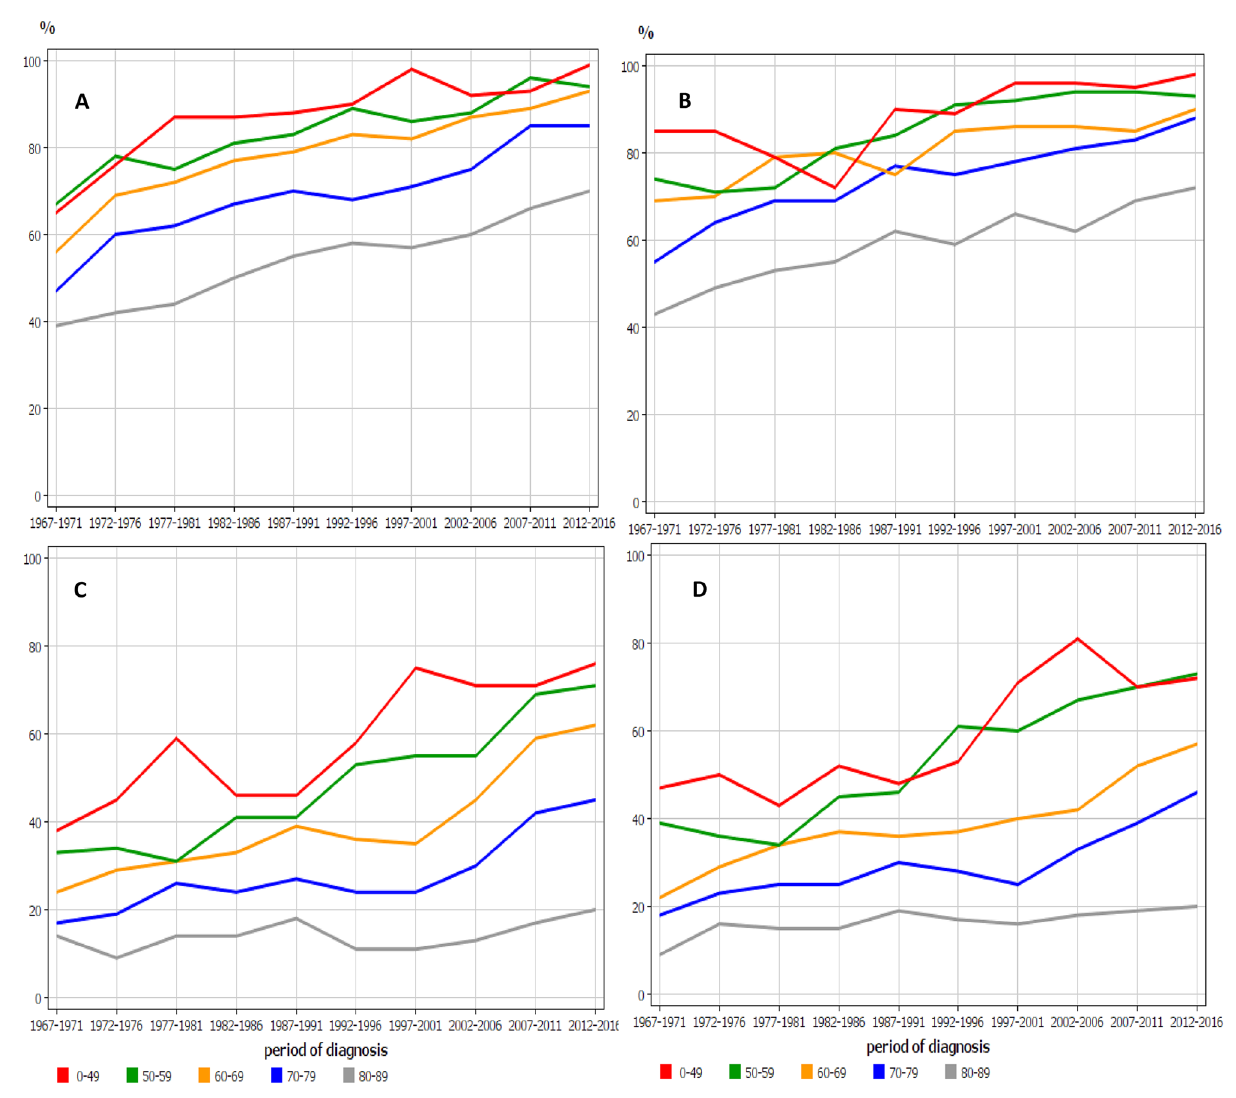
Figure 4. Age-specific 1-year relative survival for MM in men ( A ) and women ( B ) and age-specific 5-year relative survival in men ( C ) and women ( D